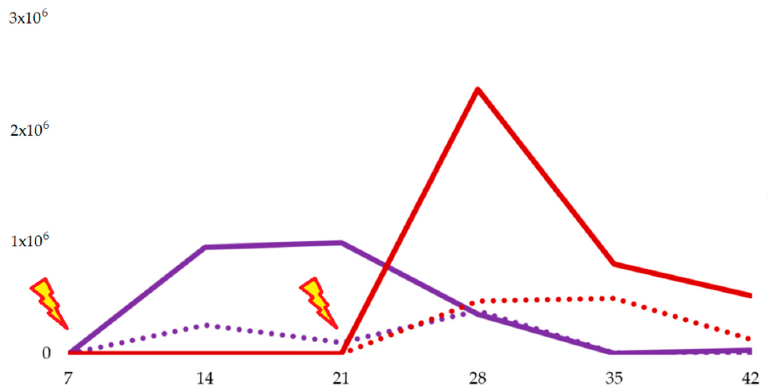
Figure 1. Results of the Salmonella spp. count in selective agar in broilers challenged with Salmonella Typhimurium at day 7 (purple lines) and day 21 (red lines) of life. Continuous lines represent control groups, whereas discontinuous lines represent treated groups, fed with fermented defatted ‘alperujo’. The Salmonella spp. count by culture (CFU/g) is shown on the vertical axis, and samplings (7, 14, 21, 35, or 42) on the horizontal axis.